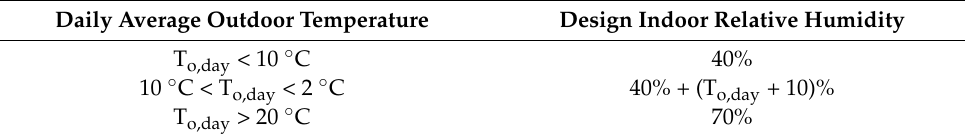
Table 6. Hourly indoor design relative humidity